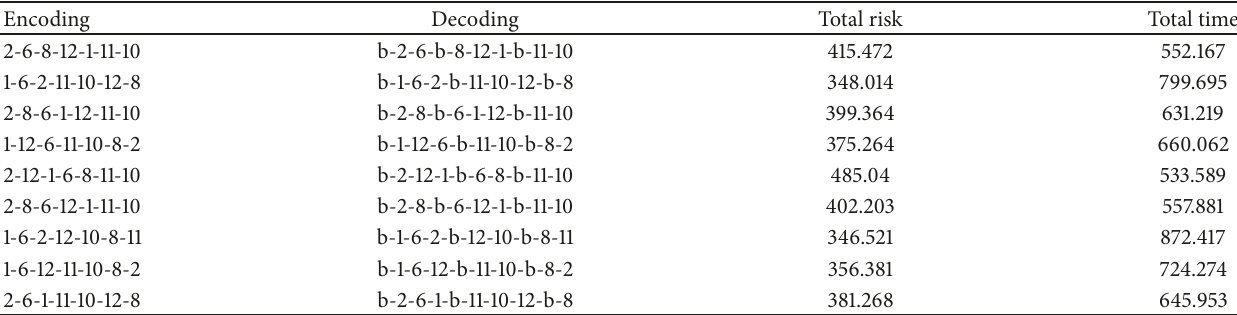
Table 9: Pareto solution set of robust control parameters Γ =10 for distribution center b.